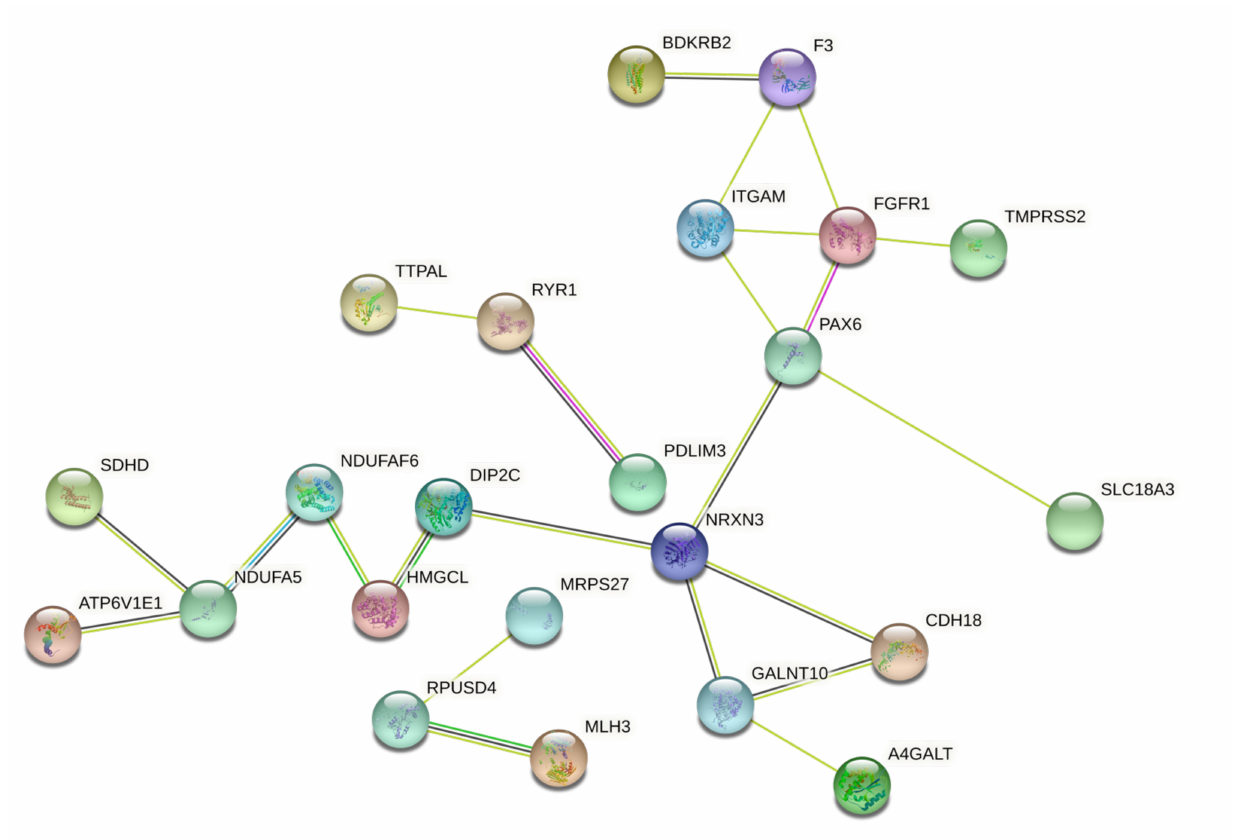
Figure 7. STRING PPI network observed for the 31 genes with altered methylation status after pesticide